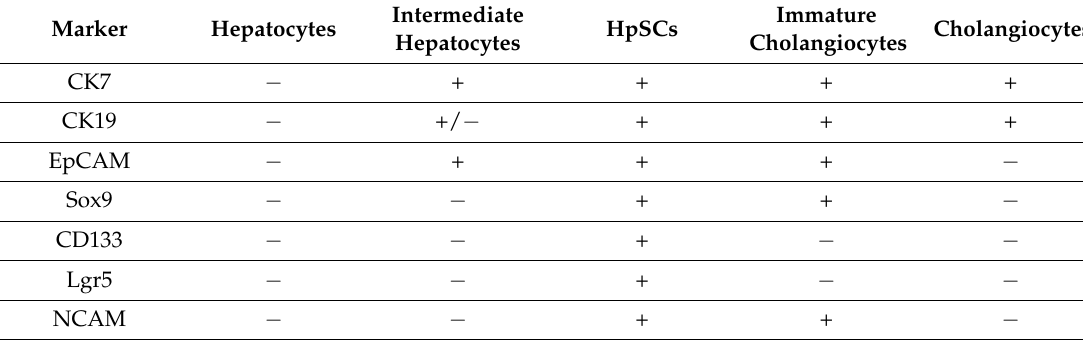
Table 1. Immunophenotype of Hepatic Stem/progenitor Cells (HpSCs) and their progeny in human